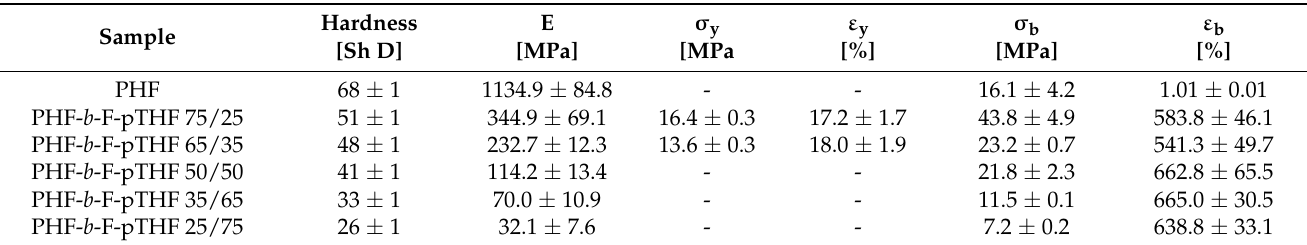
Table 3. Tensile properties of PHF- b -F-pTHF